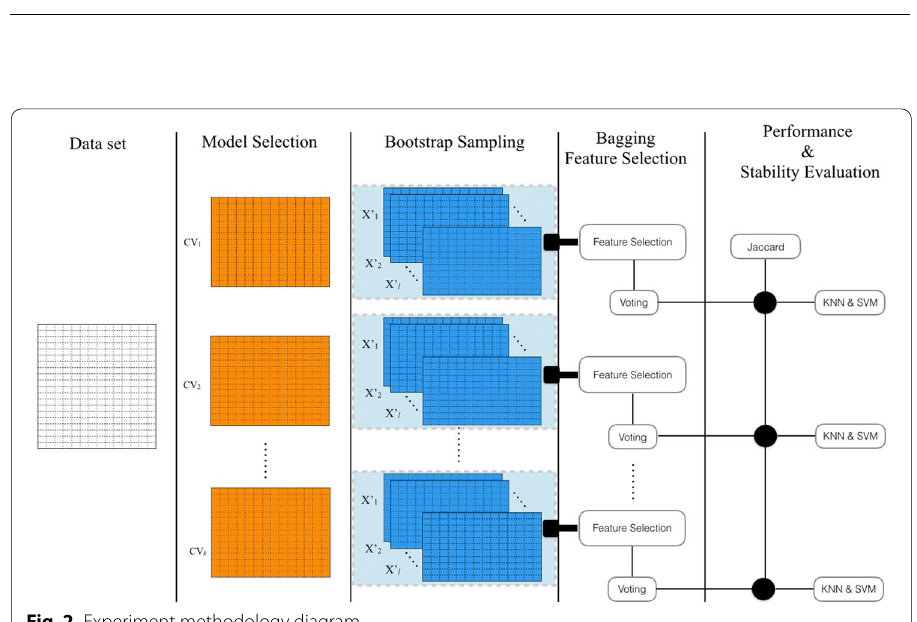
Fig. 2 Experiment methodology